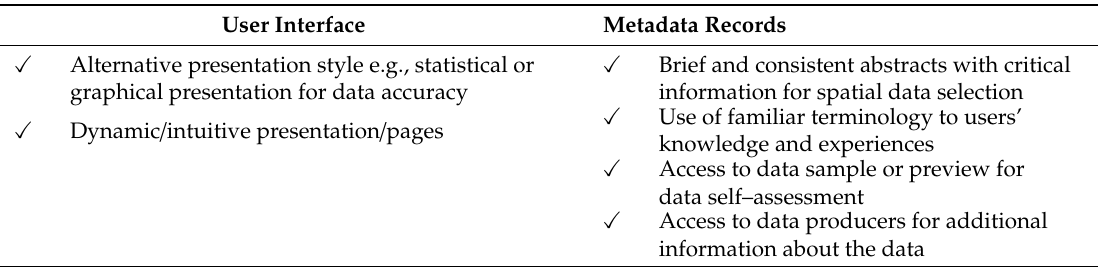
Table 9. Identified users’ expectations for spatial data selection.